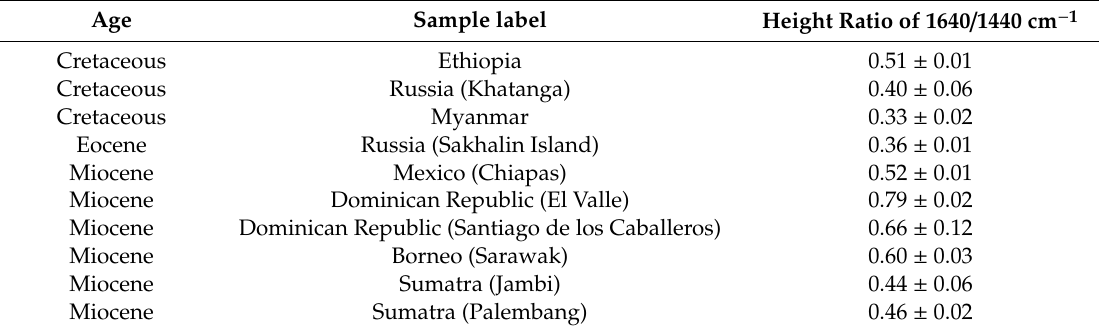
Table 3. Comparison of bands height ratios I(1640 / 1440) calculated on the basis of portable spectrometer